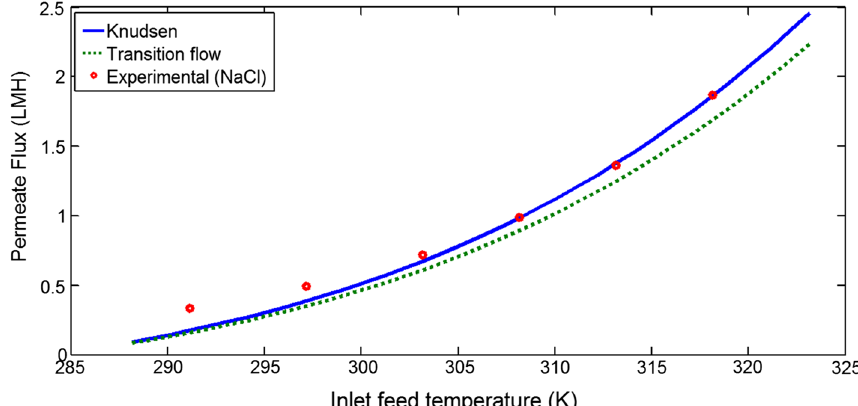
Fig. 8 Knudsen theoretical model best fitted the membrane performance of the synthetic NaCl